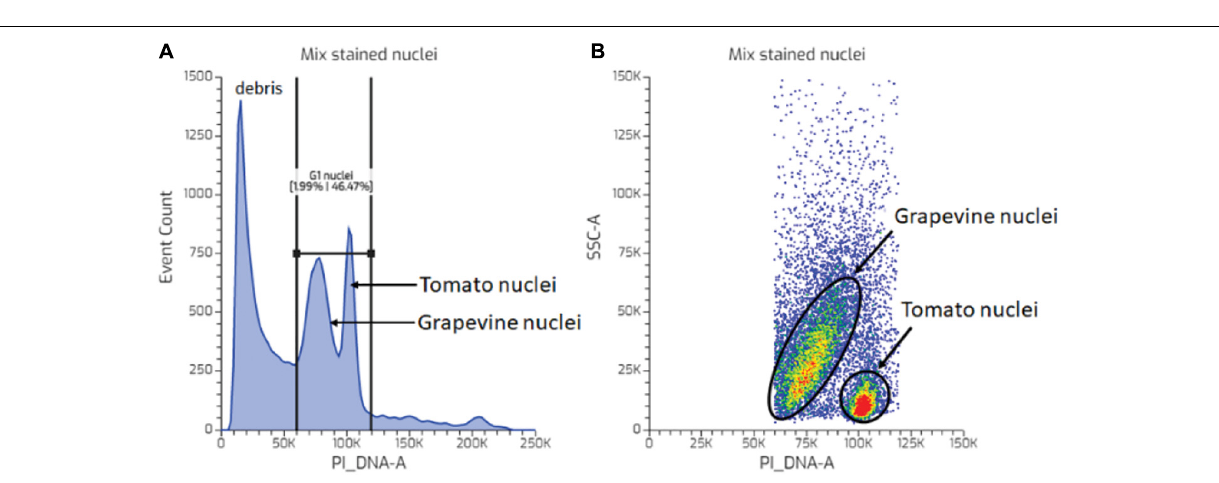
FIGURE 2 | FCM data processing illustrated using nuclei suspension prepared from tomato (A–E) and grapevine buds (F–J) . PI-positive events were extracted by creating a rectangular gate in the forward scatter area (FSC)-A vs. PI_DNA-A dot plot (B,H) . The “PI-positive” gate was positioned so that it excluded the background noise observed in the unstained sample (A,F) . Weakly fluorescing debris at lower PI_DNA channels was excluded by creating a gate between the PI-stained nuclei population (C,H) . Debris-coated nuclei were excluded by plotting the “PI-stained nuclei” into the FCS-A vs. side scatter area (SSC)-A dot plot and creating a polygonal gate around the intact nuclei population (D,I) . The proportion of nuclei in G1 and G2 phases was modelled using a Watson pragmatic algorithm (Watson et al., 1987) from the intact nuclei population (E,J) . Colors in dot plot indicate nuclei population density, being red as the highest and blue the lowest.